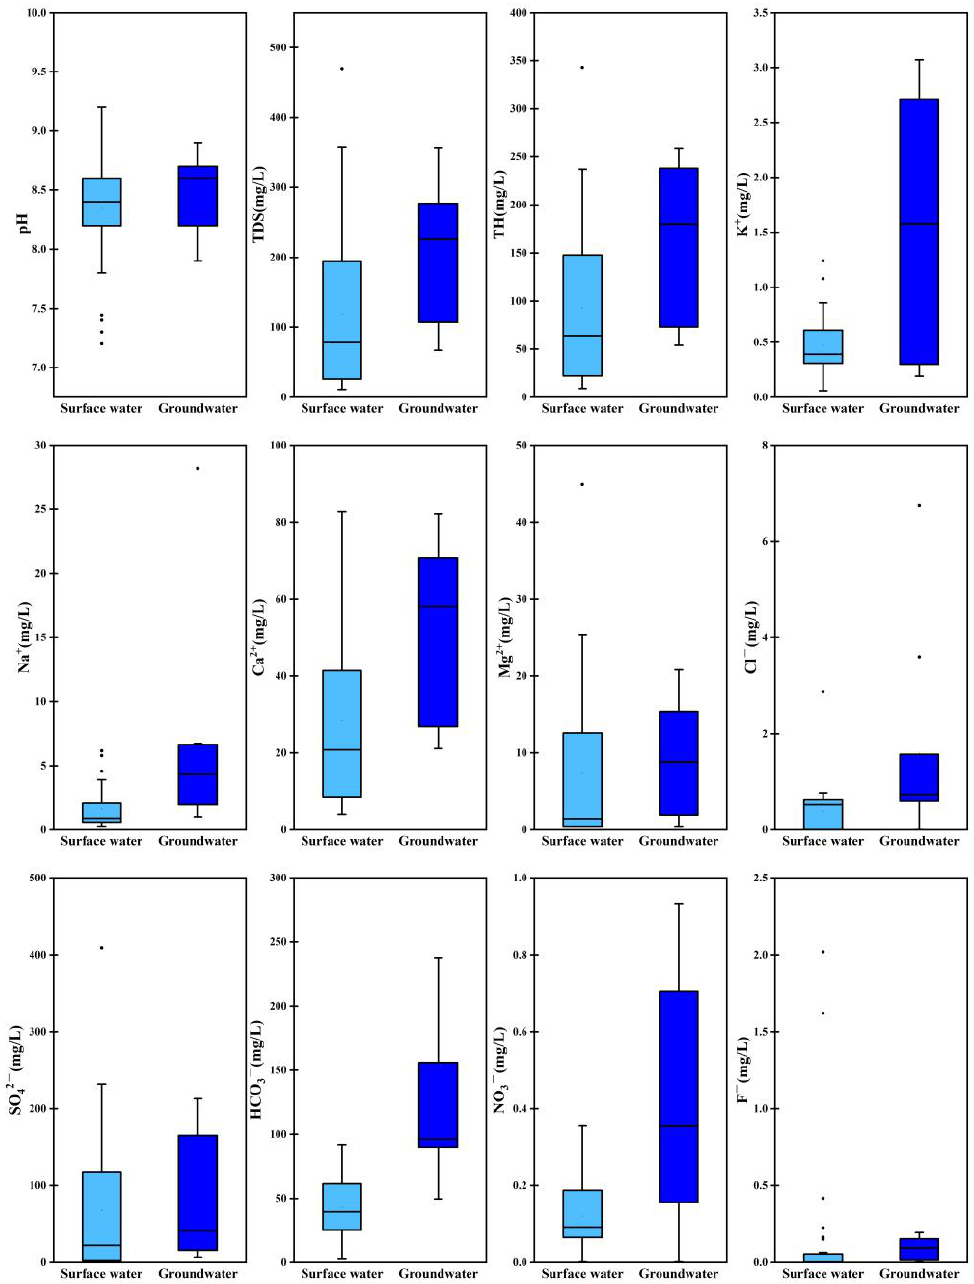
Figure 2. Box diagram of hydrochemical parameters of surface water and groundwater in the lower reaches of Yarlung Zangbo River. Data are from Table 1.